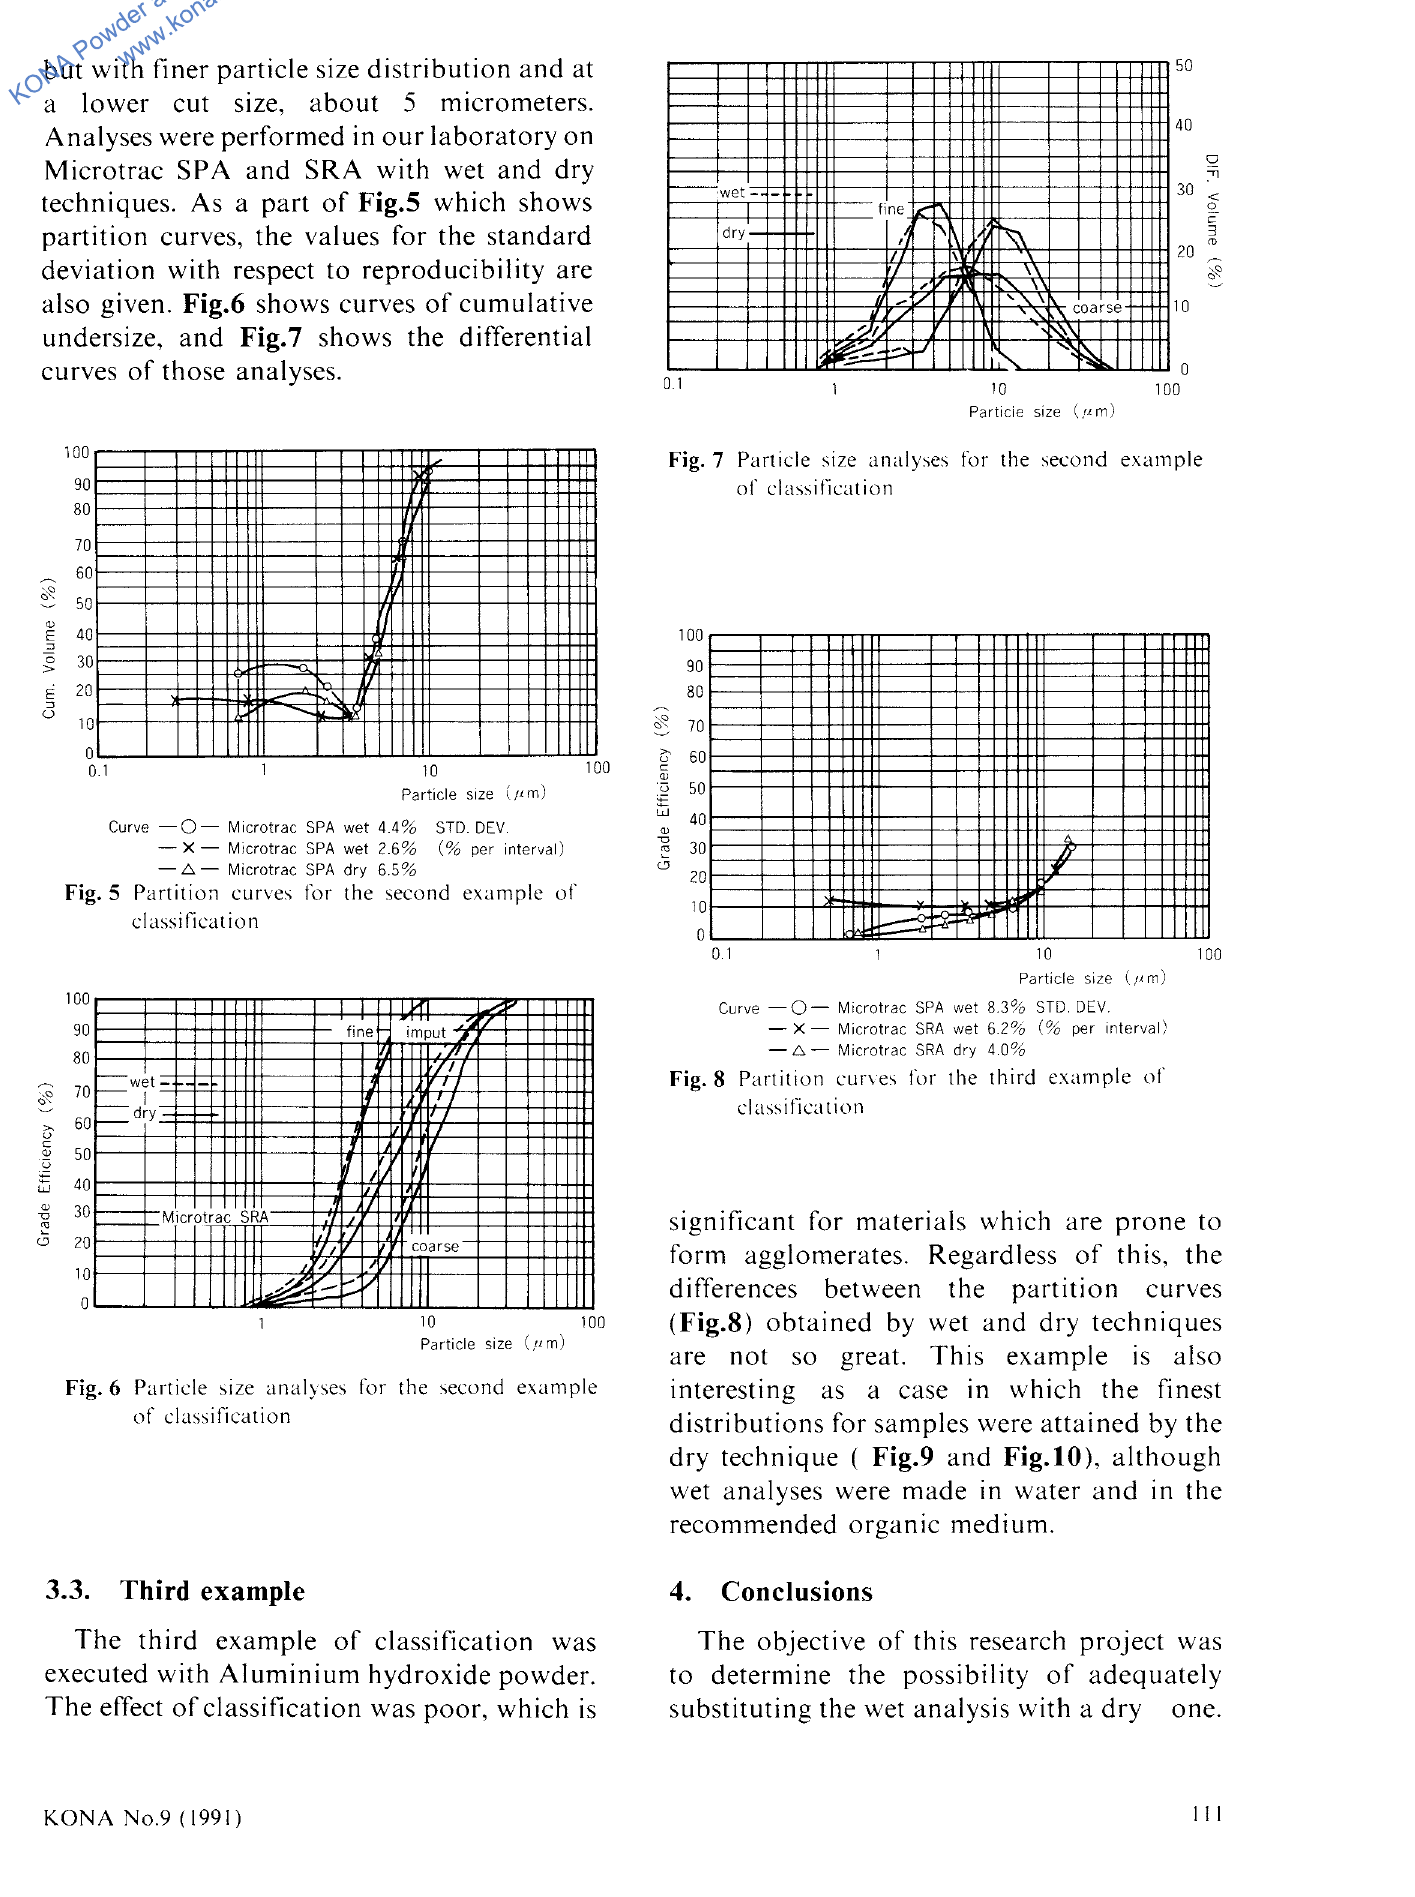
Fig. 7 Particle size analyses for the second example of classification